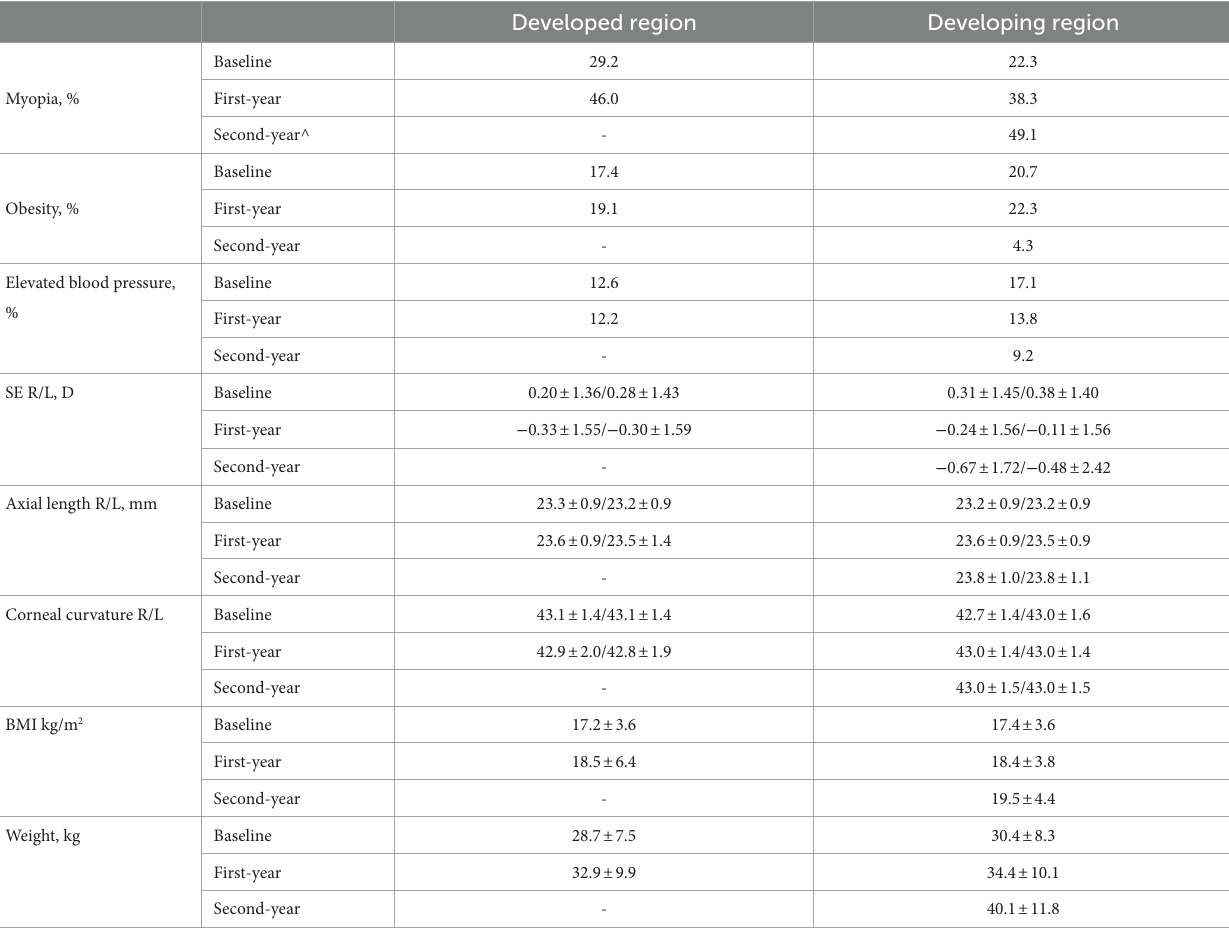
TABLE 2 Baseline and 2-year follow-up of annual physical examination of Eastern China Student Health and Wellbeing Cohort Study. Developed